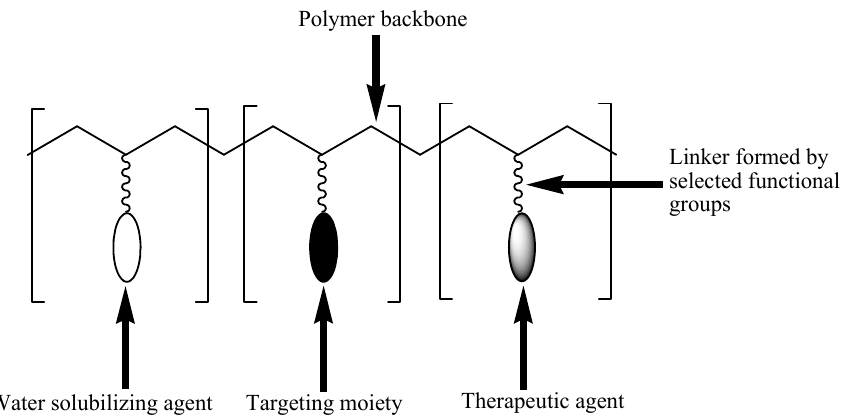
Figure 2. Schematic diagram of the Ringsdorf model of polymer-drug conjugates.